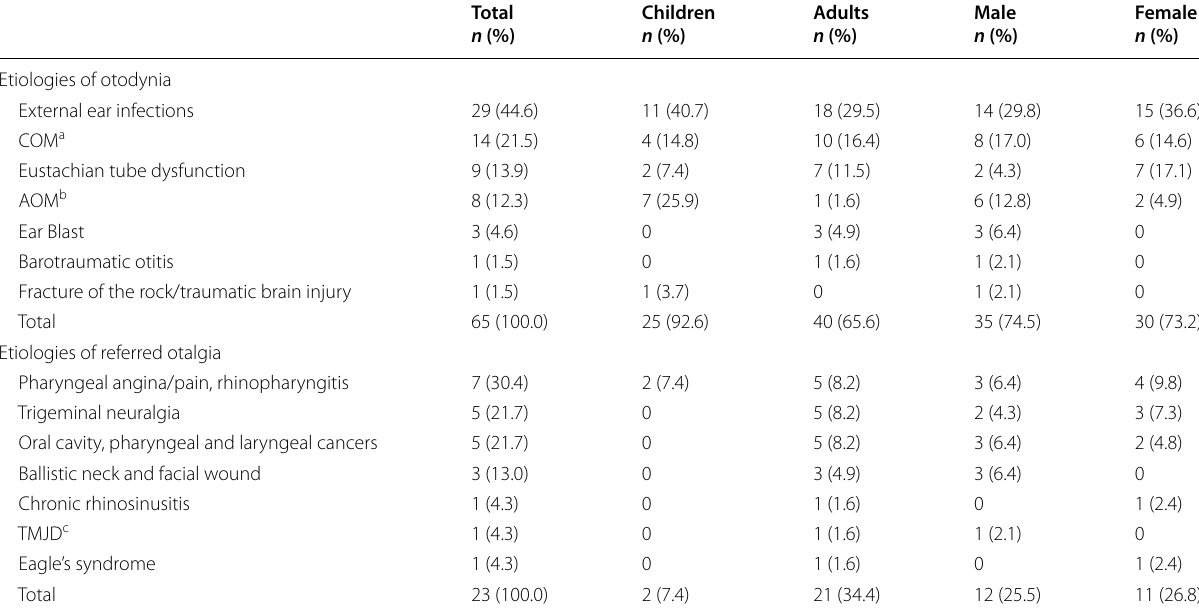
Table 2 Distribution of aetiologies of otalgia by age group and sex